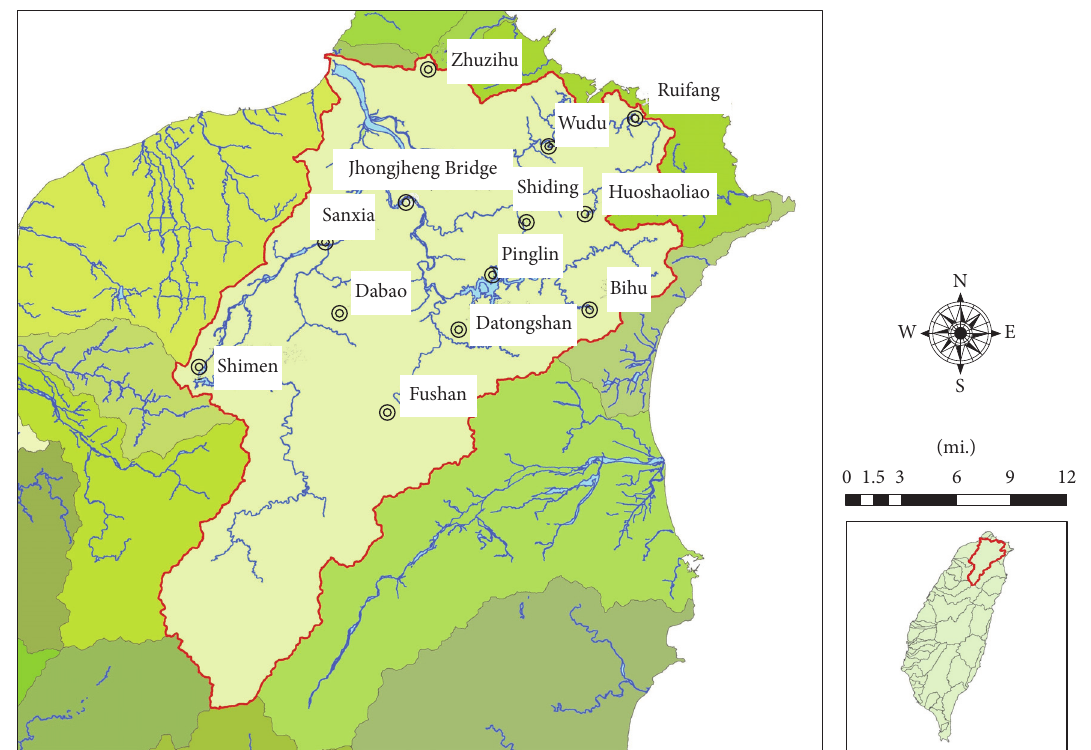
Figure 1: Location of Tamsui River Basin and the 13 rain